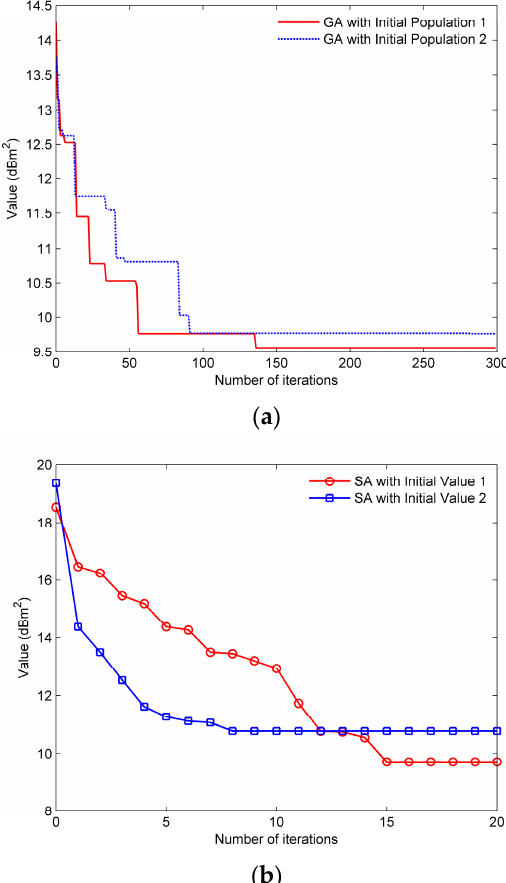
Figure 8. The curve of the objective function value changing with the number of iterations. ( a ) The result of GA with different initial population; ( b ) The result of SA with different initial value.